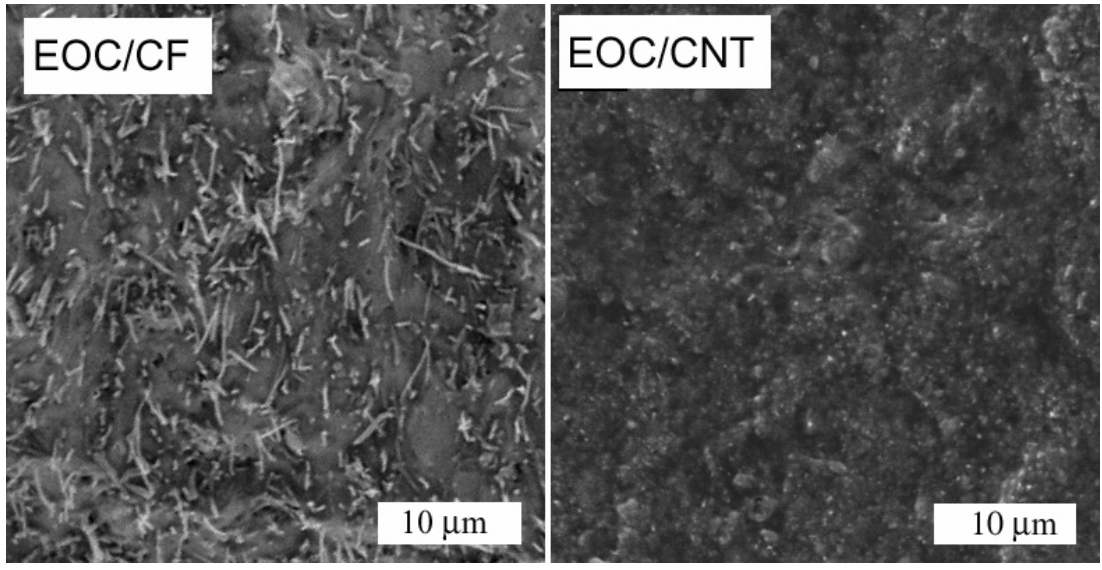
Figure 2. SEM images of fractured surface of EOC/CF composites (20 wt % CF) and EOC/CNT composites (25 wt %